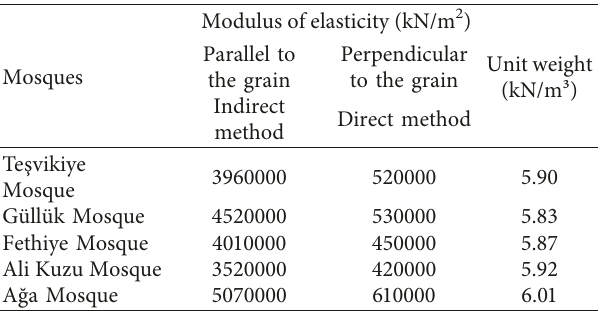
Figure 6: The finite element model and DOF system of the G¨ull¨uk Mosque